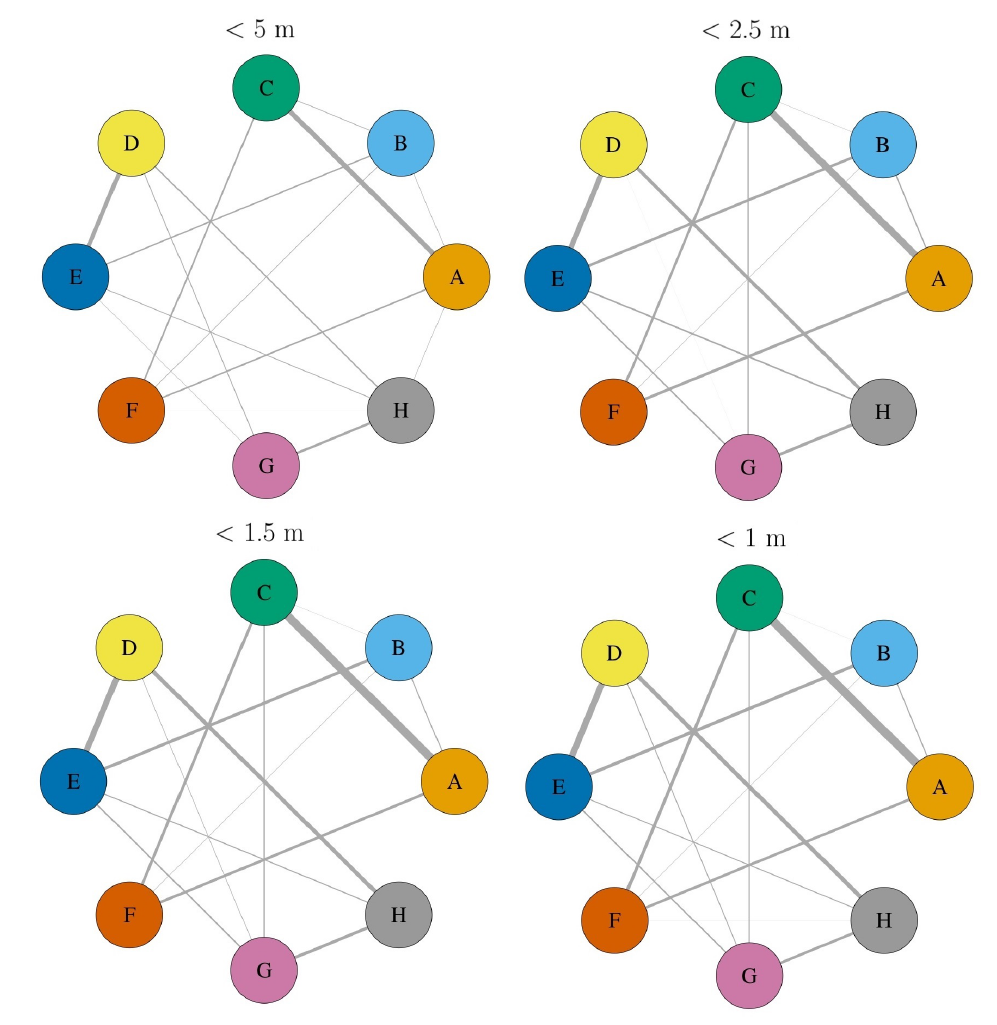
Figure 4. Social networks of the eight heifers in the pasture based on the PPMI APC values for different distance thresholds used to define a contact. Heifers are presented as nodes and labeled by their ID, and edges indicate a positive association according to their PPMI APC values. The edge width reflects the strength of this association. Please note that Heifers H and F are connected in the networks of the 1 m and 5 m distance thresholds, but since this association is close to zero, it is barely